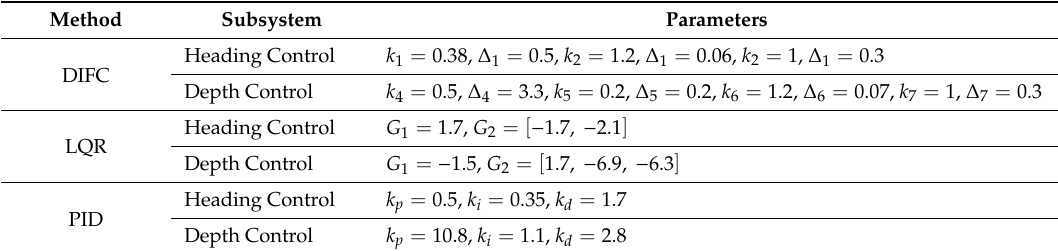
Table 2. Control parameters